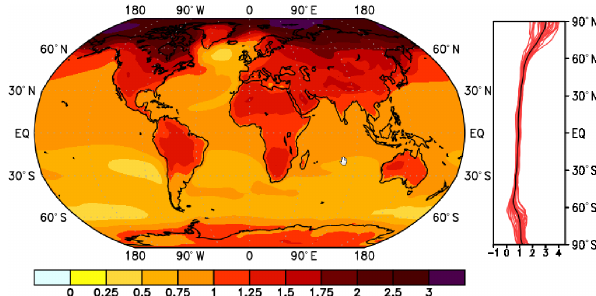
Figure 1. Polar amplification in projections of future climate change. Temperature change patterns are derived from 31 CMIP5 model projections driven by RCP8.5, scaled to 1 ◦ C of global mean surface temperature change. The patterns have been calculated by computing 20-year averages at the end of the 21st (2080–2099) and 20th (1981–2000) centuries, taking their difference and nor- malising it, grid point by grid point, by the global average tempera- ture change. Averaging across models is performed before normal- isation, as recommended by Hind et al. (2016). The colour scale represents degrees Celsius per 1 ◦ C of global average temperature change. Zonal means of the geographical patterns are shown for each individual model (red) and for the multi-model ensemble mean